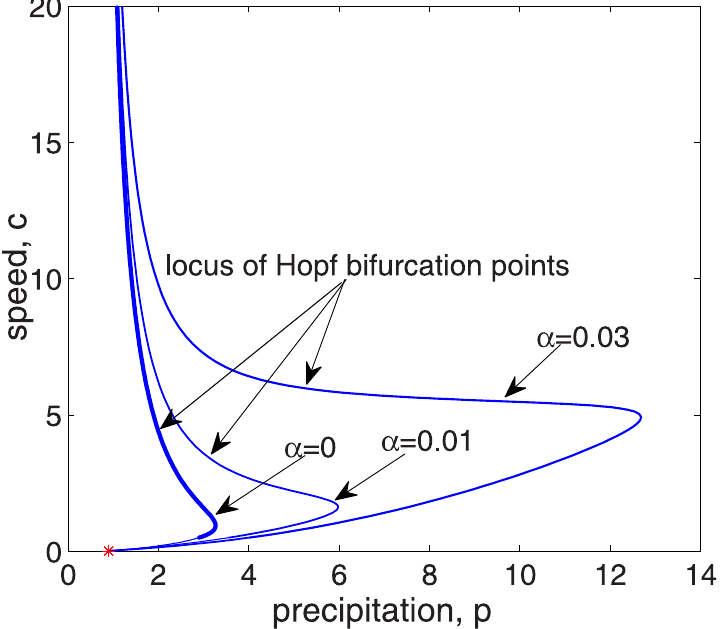
Fig 5. Effects of α on the parameter space where periodic pattern solution is predicted by the pattern model (14). The blue lines give the loci of Hopf bifurcation points in p − c plane with different infiltration feedback levels α . The other parameter values are v = 182.5, δ =